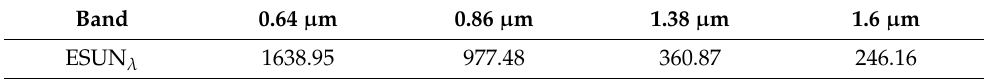
Table 1. Mean solar exoatmospheric irradiance from visible to NIR channels of GK-2A.